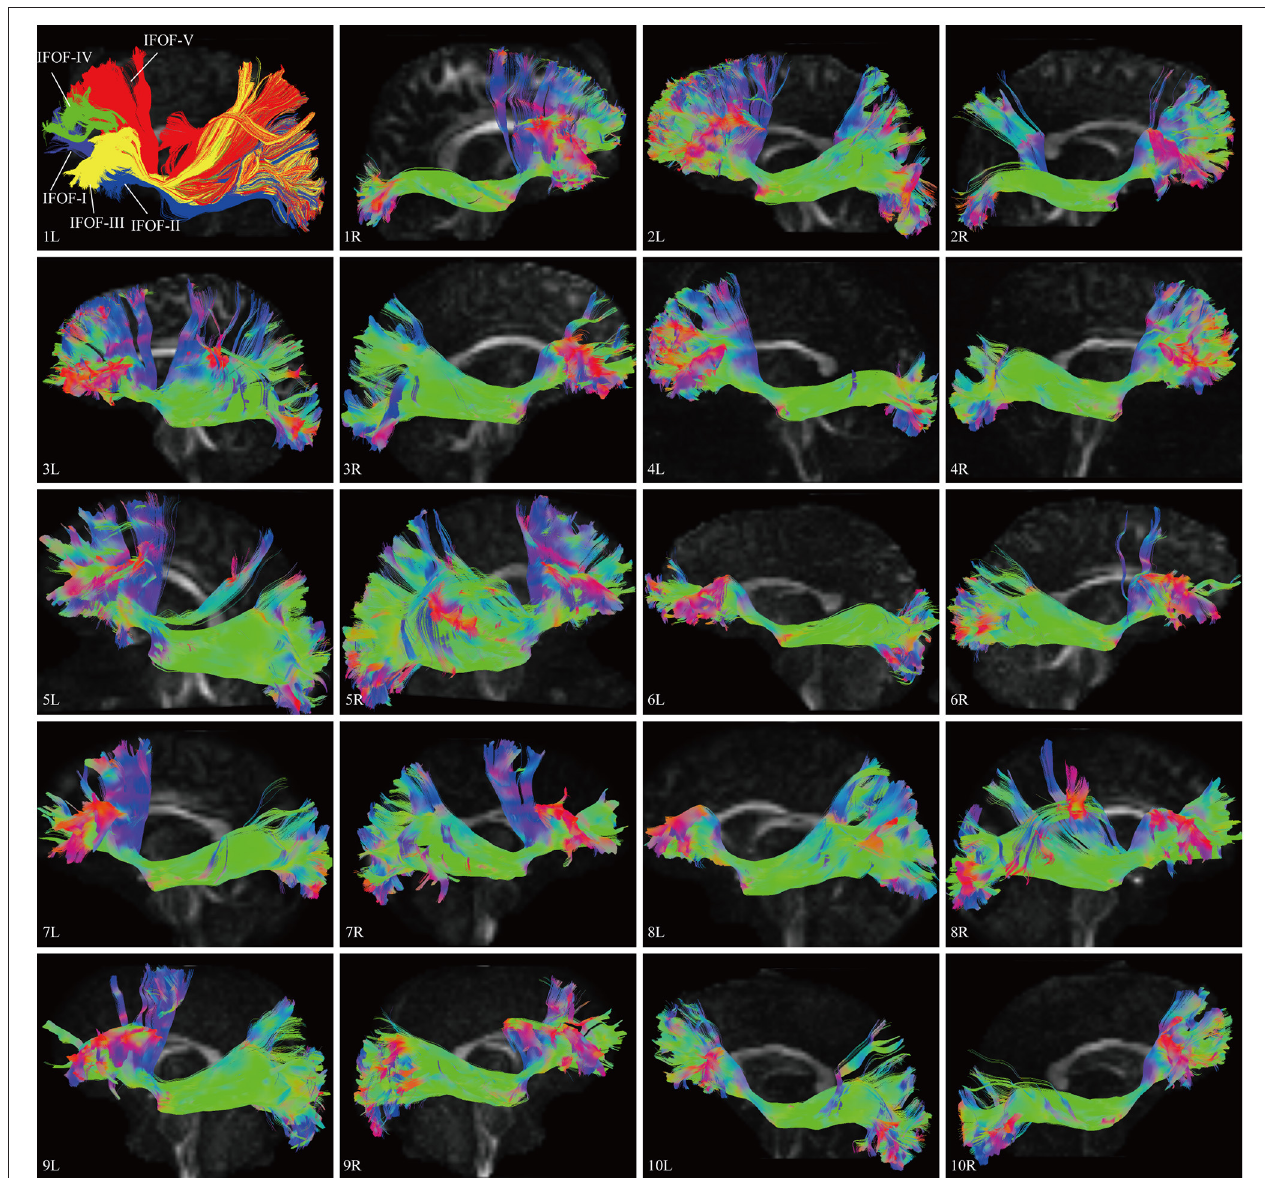
FIGURE 2 | DSI tractography studies of the IFOF in 20 hemispheres of 10 subjects on sagittal view. Order: Subject 1, 2, 3, 4, 5, 6, 7, 8, 9, 10. The IFOF was noted as a long-ranged and bowtie-shaped pathway at the inferior base of the cerebrum in all 20 hemispheres. As the fibers leaved the originations, they narrowed as a compact fascicle at the level of the external/extreme capsules, then fanned out to the terminations. Greater inter-subjects connective variabilities were demonstrated with a maximum of 40% overlap in the central part. L, left; R, right.